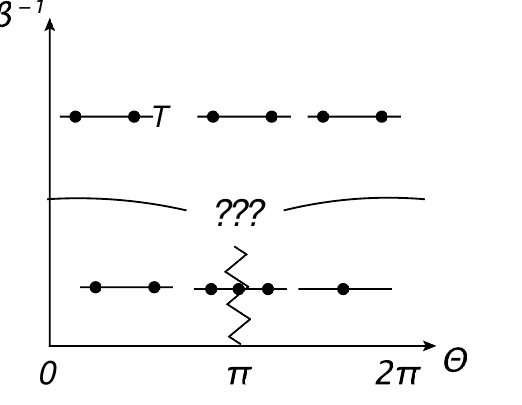
Figure 3 . The phase diagram in figure 1 with the vacua in the SO(3) + theory in the different